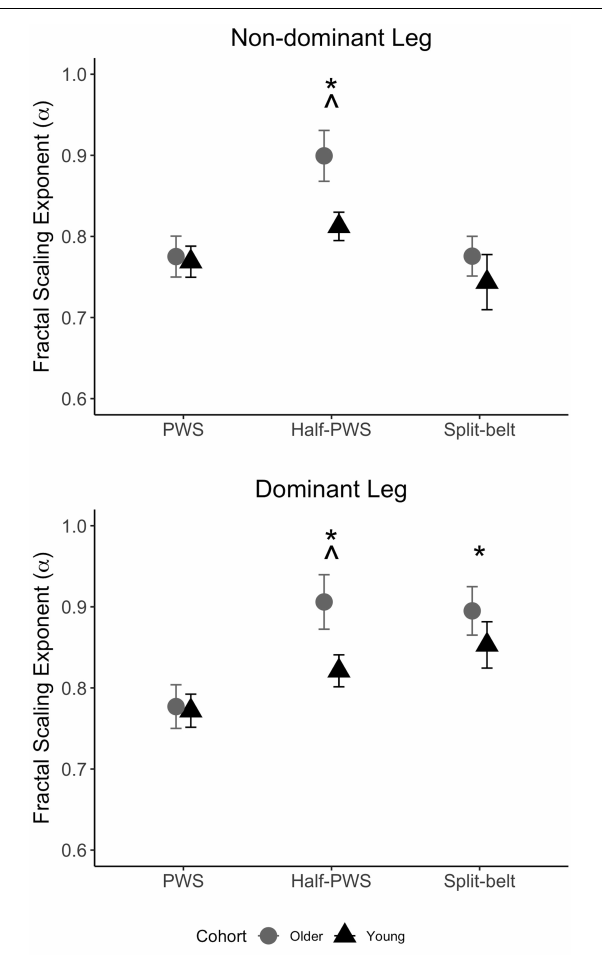
Frontiers in Physiology |